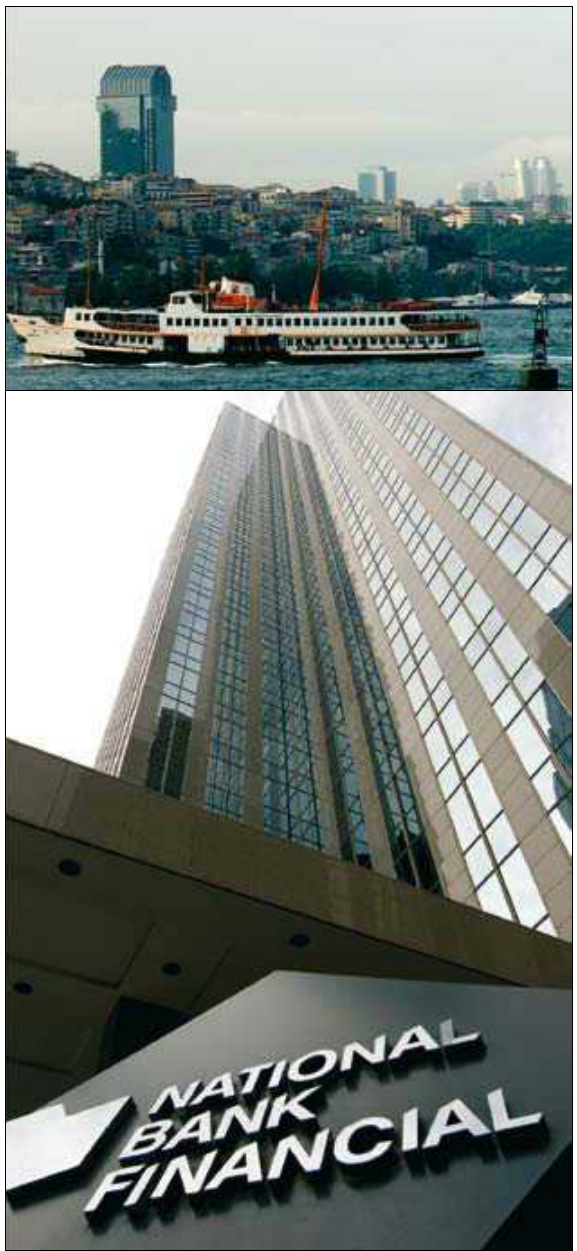
Fig. 4. buildings of high-tech style architecture in Istanbul and Toronto (author’s photos)